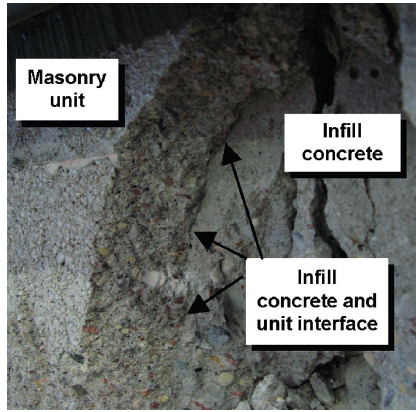
Fig. 8. Contact zone of a masonry unit and concrete